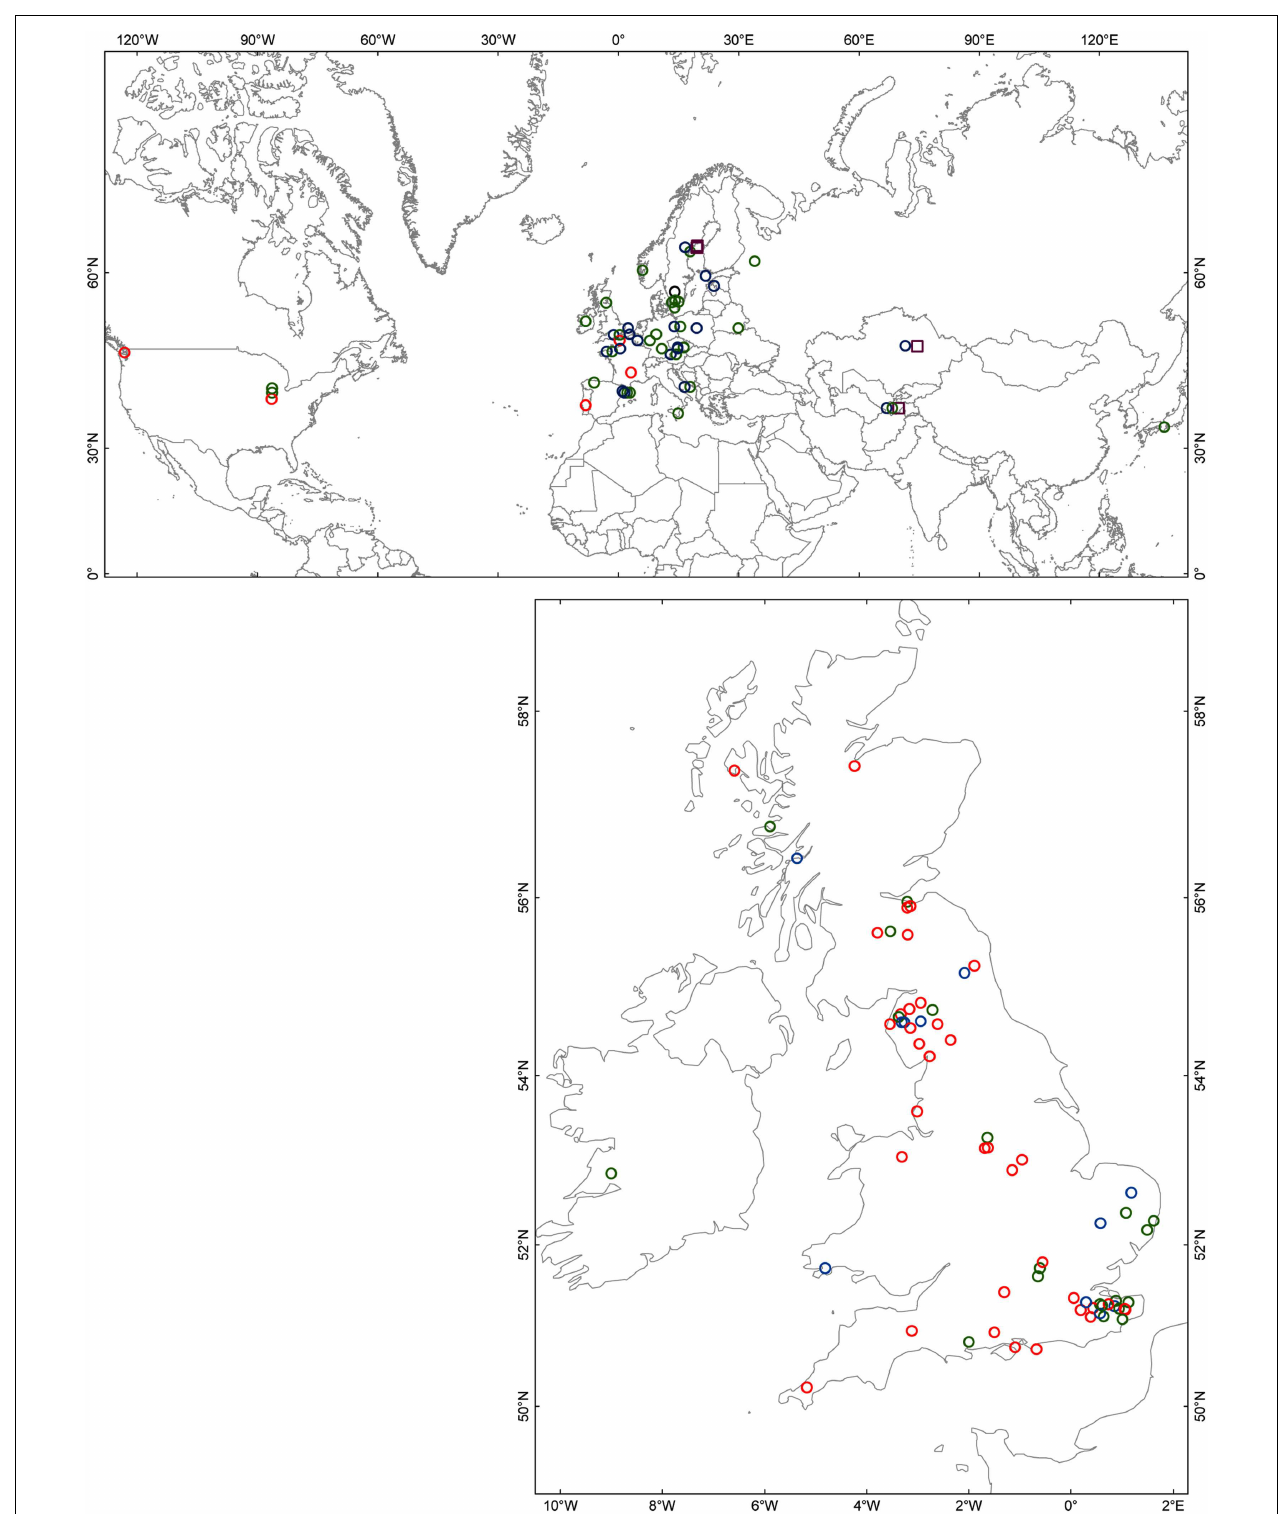
by a black open circle; matching Col-0 reference (i.e., lacking both diagnostic markers) by blue open circles; presence of the larger indel/inversion as found in Kz-1 and Kondara by open purple squares. (This indel/inversion was detected by the digestion pattern of CAPs marker 2 in combination with a larger PCR fragment